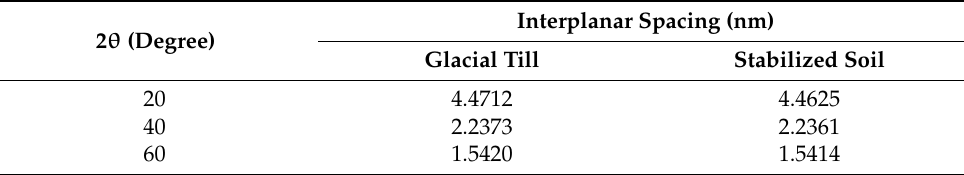
Table 3. Mineral interplanar spacings of glacial till and stabilized soil. 2 θ (Degree)